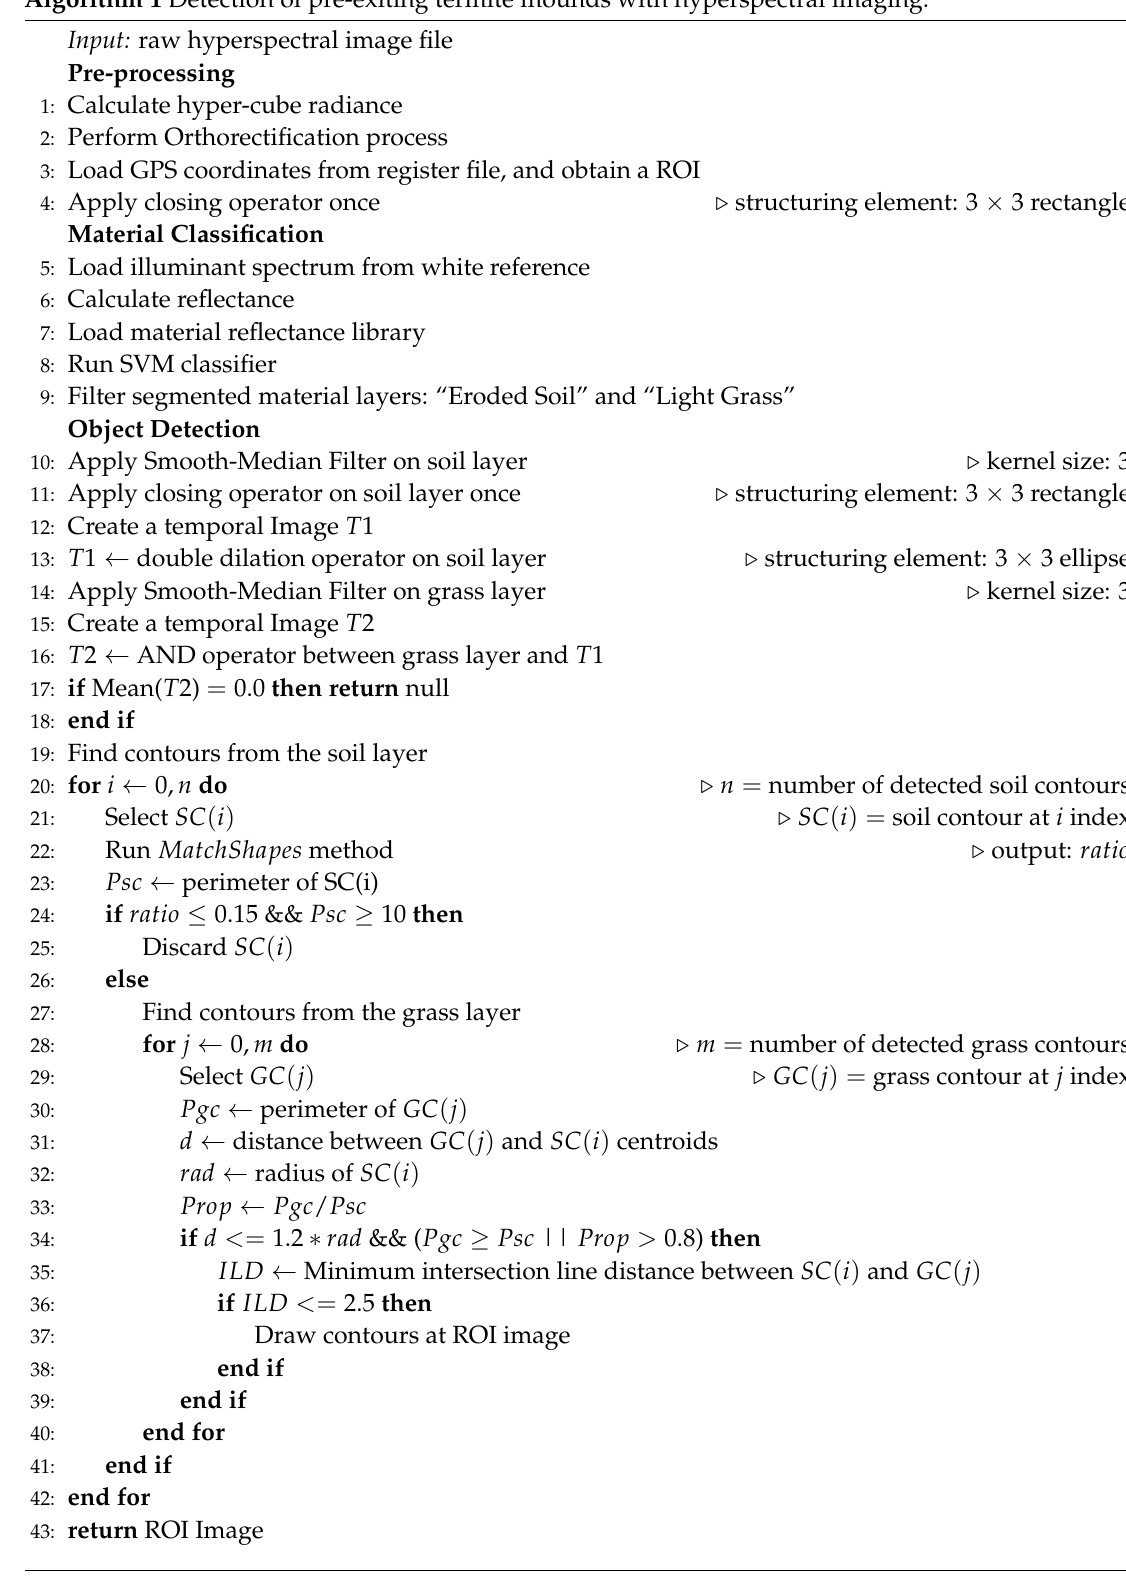
Algorithm 1 Detection of pre-exiting termite mounds with hyperspectral